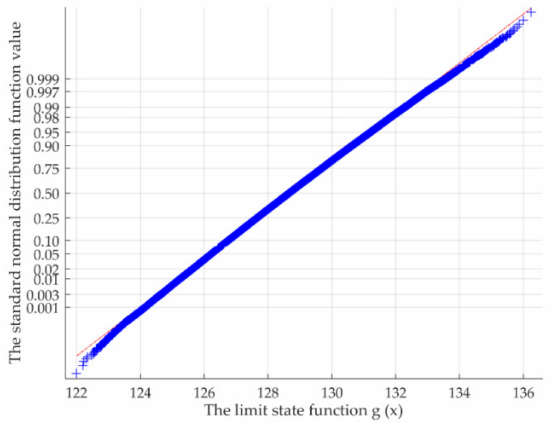
Figure 7. Normal distribution test of g ( x